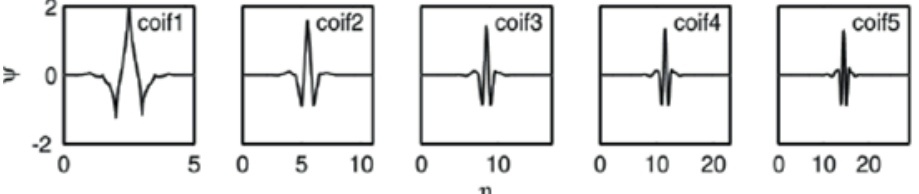
Fig. 2 Coiflet wavelets (from order N equal to 1 up to